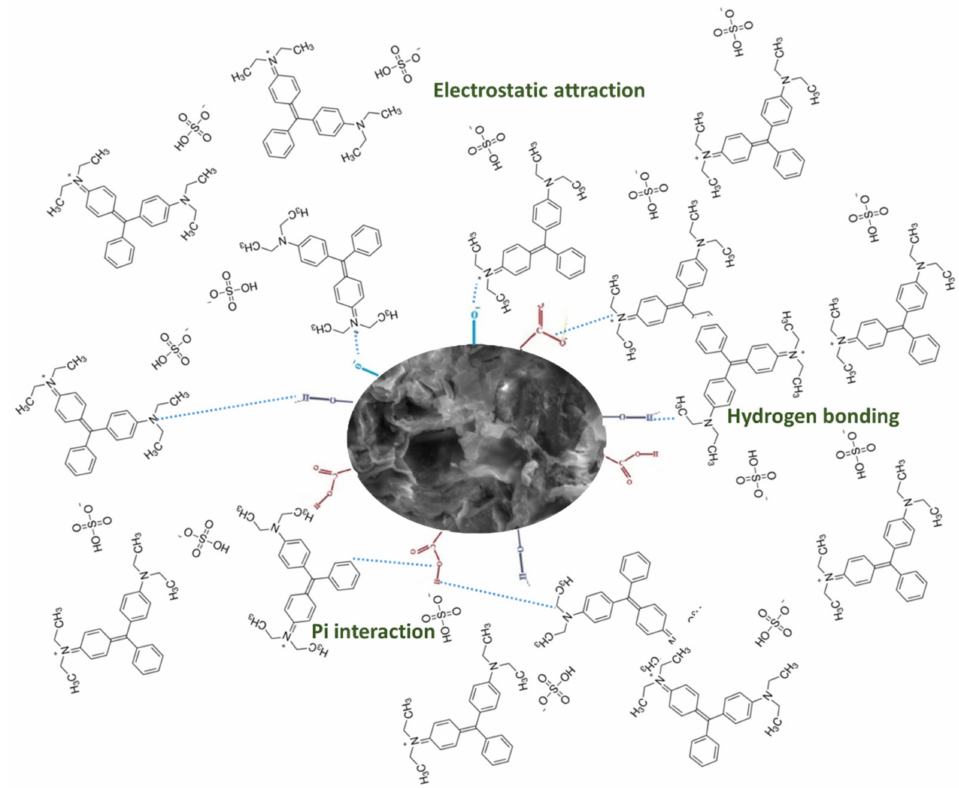
Figure 12. Mechanism of adsorption of BG dye on F. benghalensis leaves